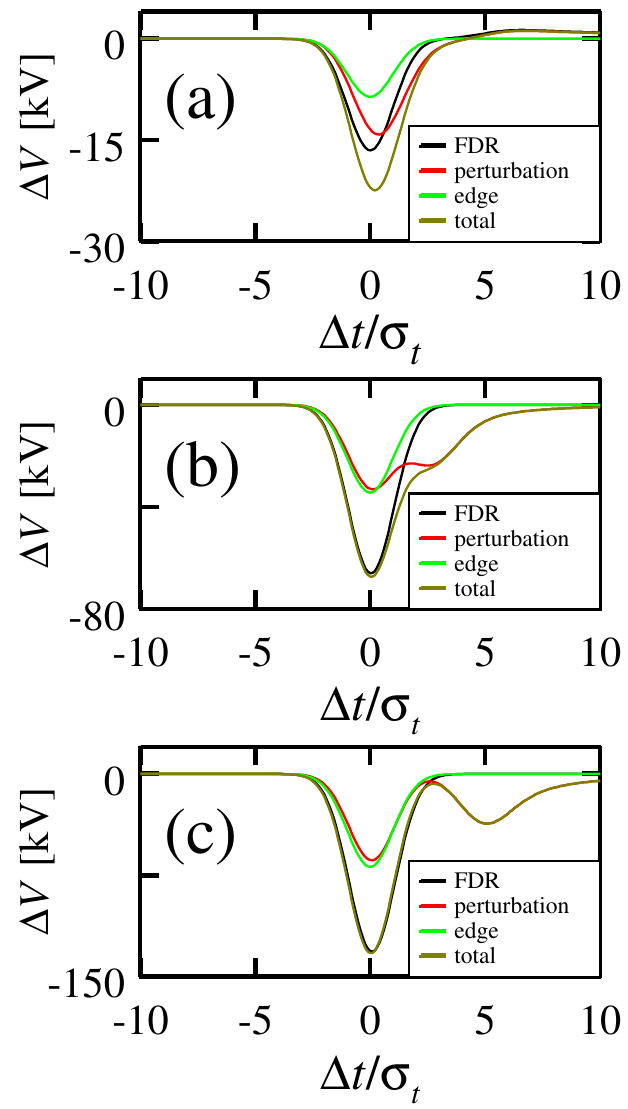
FIG. 5. (Color) Integrated coherent-radiation wakes of a disk target with inner radius of 2 mm and outer radius of 20 mm, located 1 m downstream of a bending magnet exit. The wakes are integrated over a distance of 10 m downstream of the target, for a 511-MeV, 200-pC Gaussian bunch. We show the edge- radiation wake when there is no target, the perturbation from the target, and the total coherent-radiation wake given by their sum. For comparison, the FDR wake is shown for a target that is far downstream of a bending magnet. (a) (cid:3) z ¼ 400 (cid:9) m . (b) (cid:3) z ¼ 100 (cid:9) m . (c) (cid:3) z ¼ 50 (cid:9) m